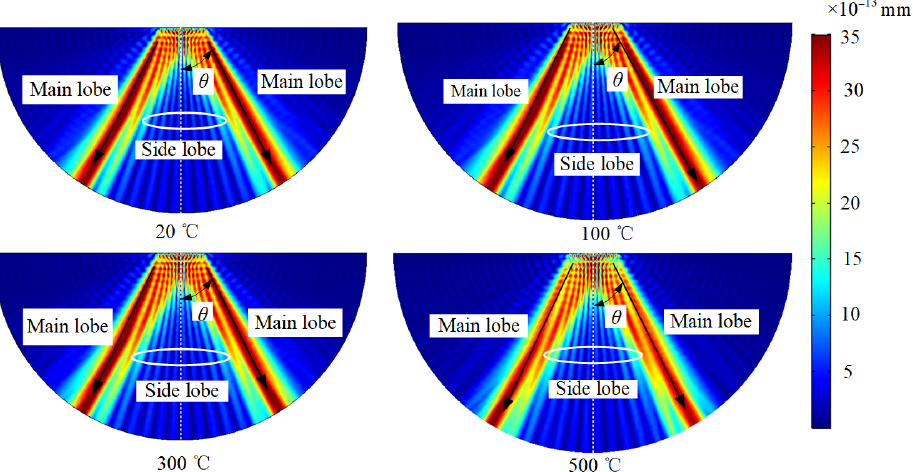
Figure 8. Acoustic radiation field of angled SV wave EMAT in carbon steel specimens at different temperatures.